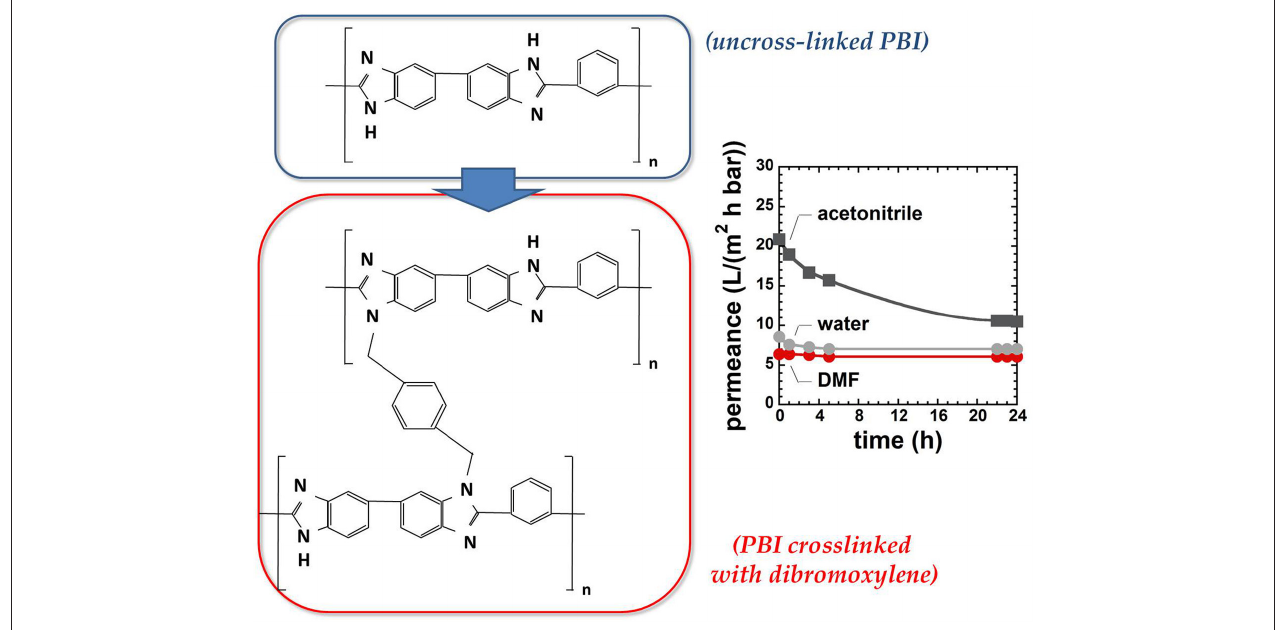
FIGURE 8 | Structure and properties of novel PBI membranes cross-linked with dibromoxylene. Adapted from Valtcheva et al. (2014), with permission of Elsevier